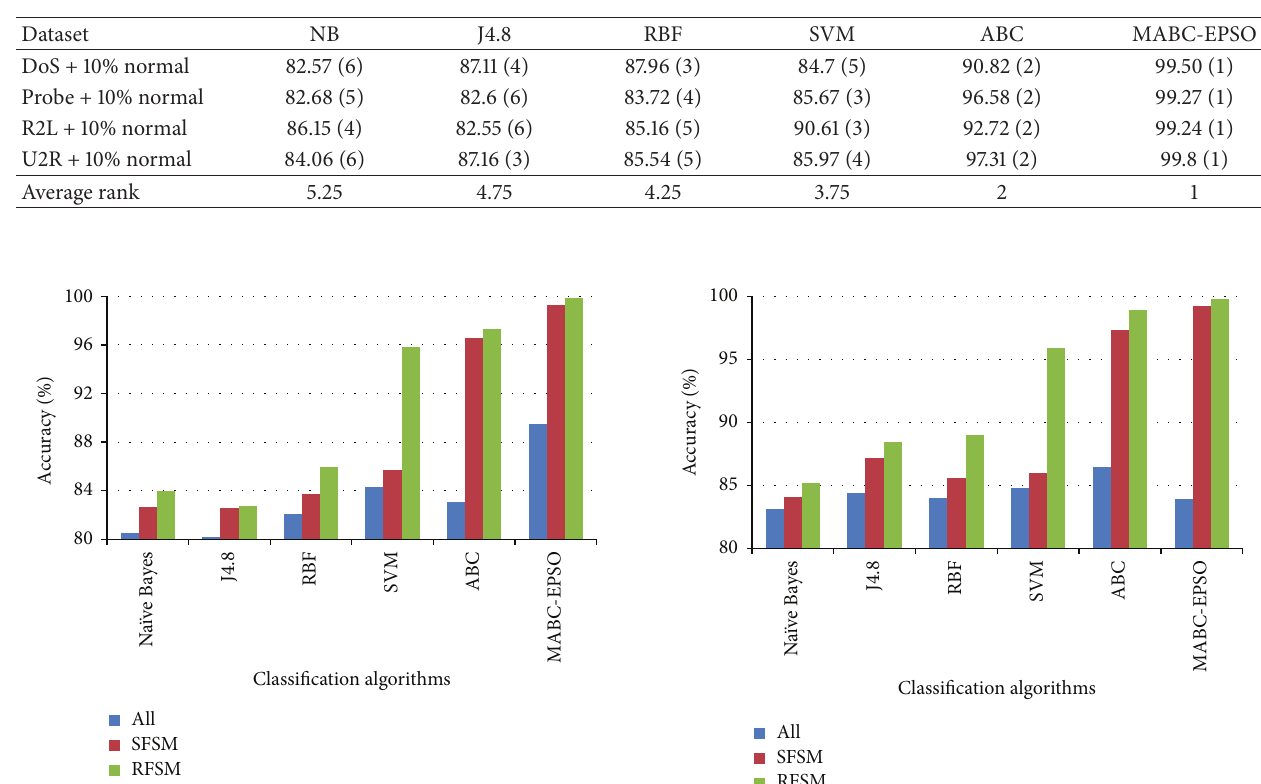
Table 9: Accuracy rates of classifiers using SFSM feature selection method and Friedman ranks.